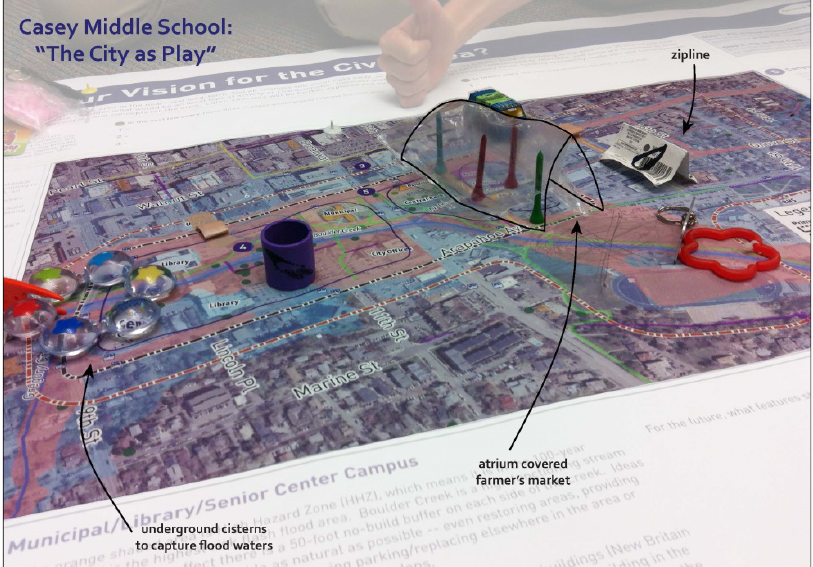
Figure 10. One of Casey Middle School students’ “City as Play” models for the Boulder Civic Area (image courtesy of Katherine Buckley).